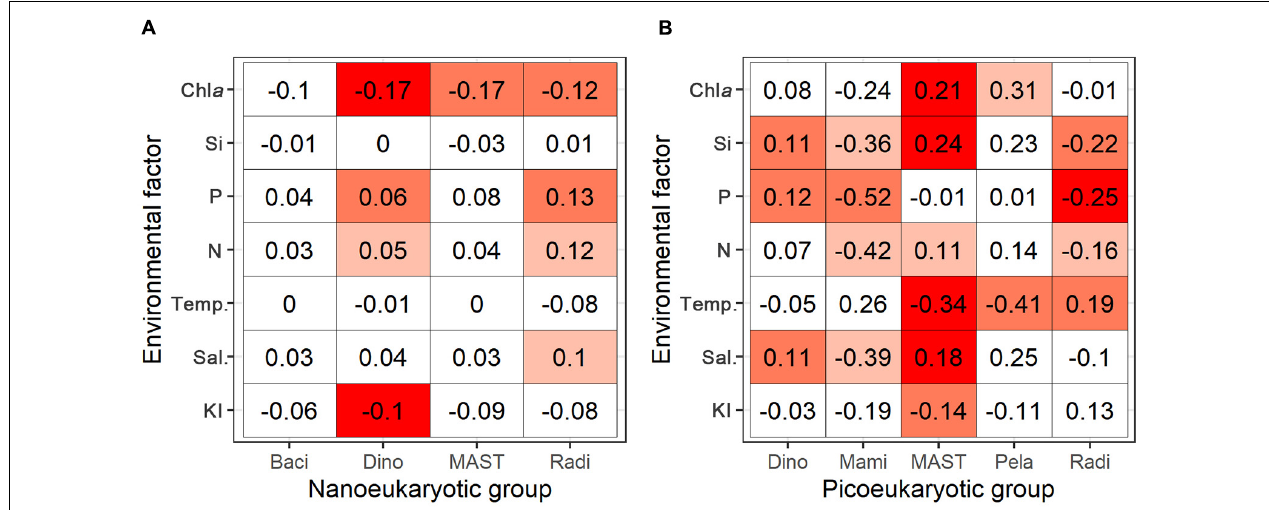
FIGURE 8 | Heatmaps of correlation matrix (spearman correlation) of the RNA: DNA ratio versus environmental factors for major groups of nanoeukaryotes (A) and picoeukaryotes (B) , including Bacillariophyta (Baci), Dinophyceae (Dino), Mamiellophyceae (Mami), MAST, Pelagophyceae (Pela), and Radiolaria (Radi). Environmental factors include Kuroshio intrusion (KI), salinity (Sal.), water temperature (Temp.), nitrate + nitrite (N), phosphate (P), silicate (Si), and chlorophyll a concentration (Chl a ). Numbers are the correlation coefficients, background colors (from dark red to white) indicate significance levels associated to the p values (0.001, 0.01, 0.05) and no